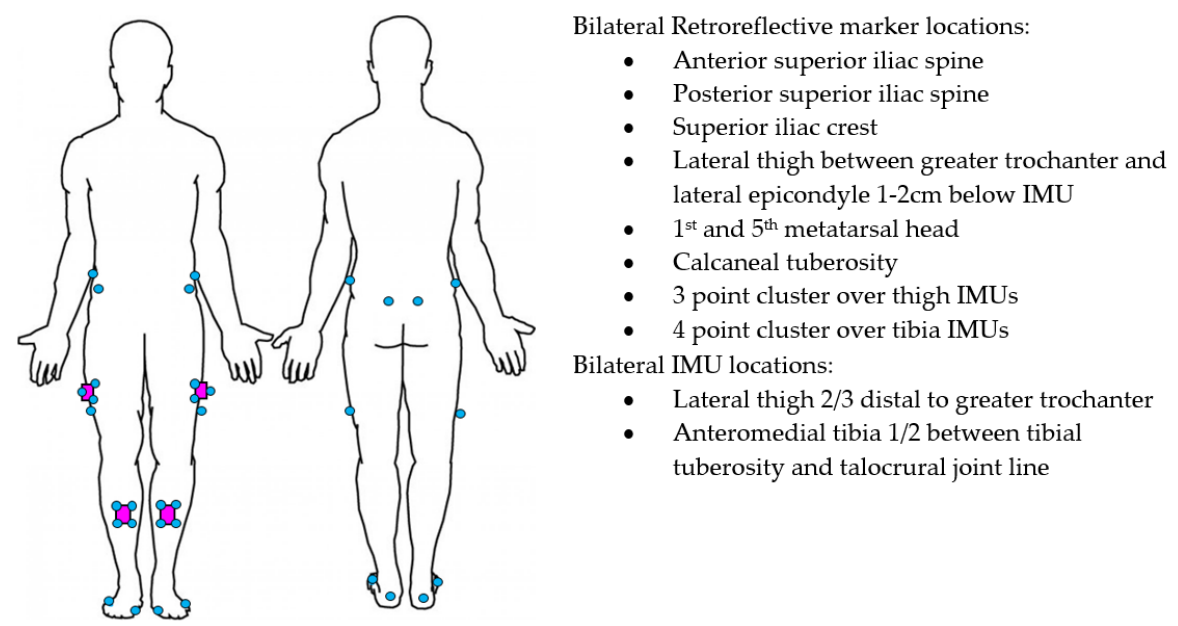
Figure 1. IMU (purple) and Vicon marker (blue)